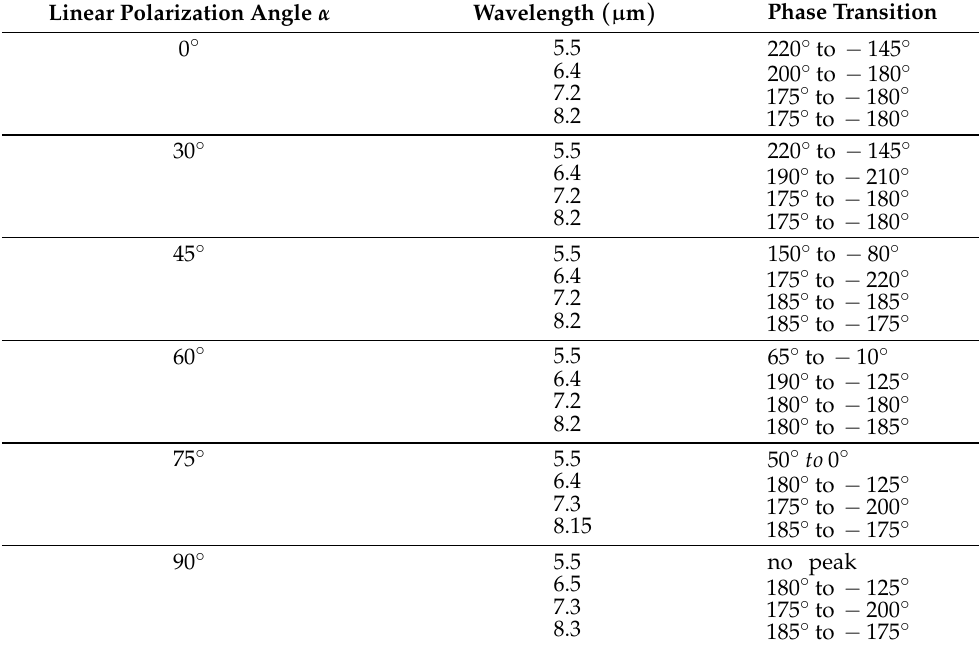
Table 6. Phase transitions associated with the reflected wave across the phase spectrum in the case of structure 2C, at linear polarization states defined by α = 0 ◦ , α = 30 ◦ , α = 45 ◦ , α = 60 ◦ , α = 75 ◦ and α = 90 ◦